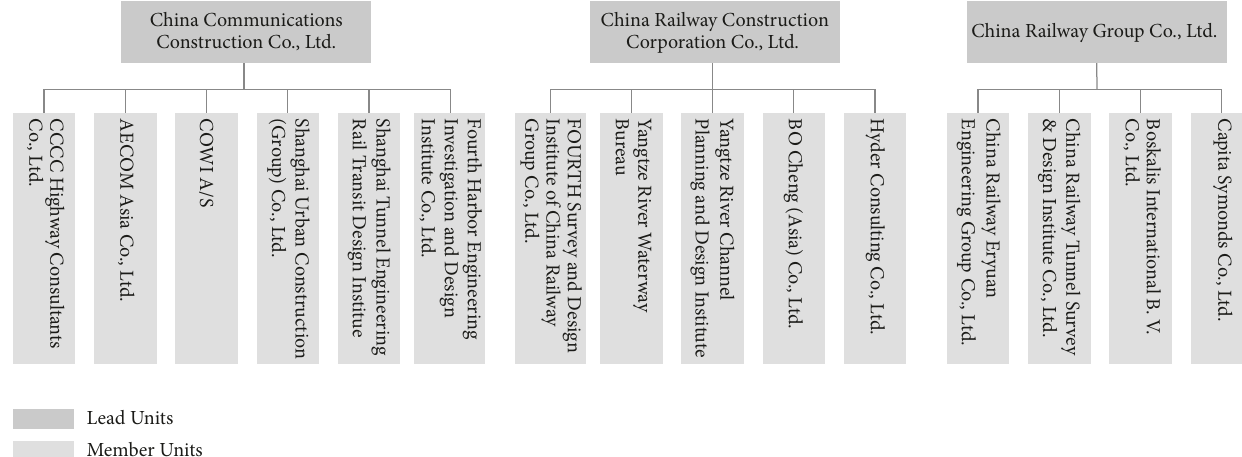
Figure 4: Three joint venture contractors of island and tunnel